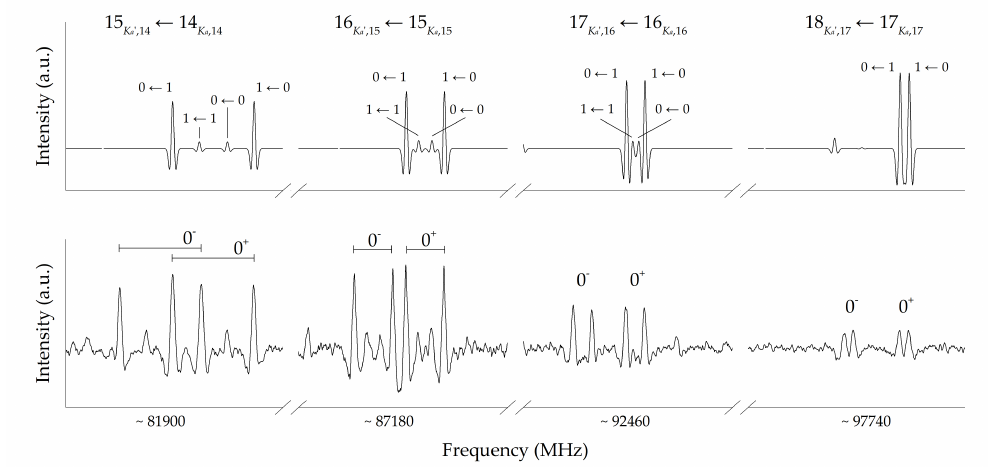
Figure 3. Simulated (based on FTMW results, top panel) and experimental (bottom panel) typical pattern of the K a = 0,1 transitions in the millimeter-wave region. A 20MHz scan is shown for each transition. The two inversion states are easily